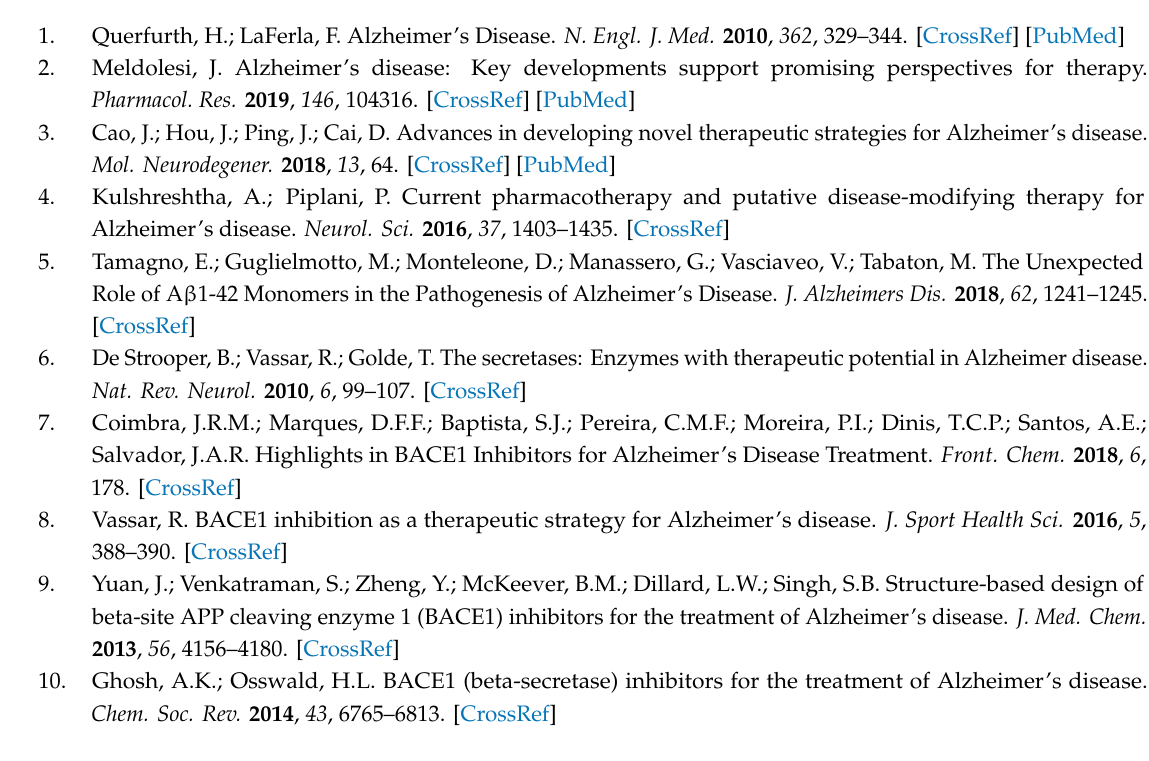
Figure S1: Training set of the SB pharmacophore modeling approach; Figure S2: Structure of the thirty-nine active set compounds against BACE1 used for the Test Set; Figure S3: 2D ligand-receptor interactions diagram of the PDB complexes used in SB pharmacophore approach; Figure S4: Overlap of the HBD and two PHBD features of the LB_Hyp1 model with the catalytic aspartic dyad of BACE1 and inter-features distance range (Å); Figure S5: Protein-Ligand Interaction Fingerprints (PLIF) analysis of the active compounds against BACE1; Table S1: Percentage of True Positive versus False Positive of pharmacophore models; Table S2: Scoring with GOLD and BACE1 percent inhibition data from the thirty-four in vitro tested compounds; Supplementary Material 2: 1 H-NMR, 13 C-NMR and 2D-NMR data for compounds 11 (AE-848 / 42798994) and 13 (AK-778 /